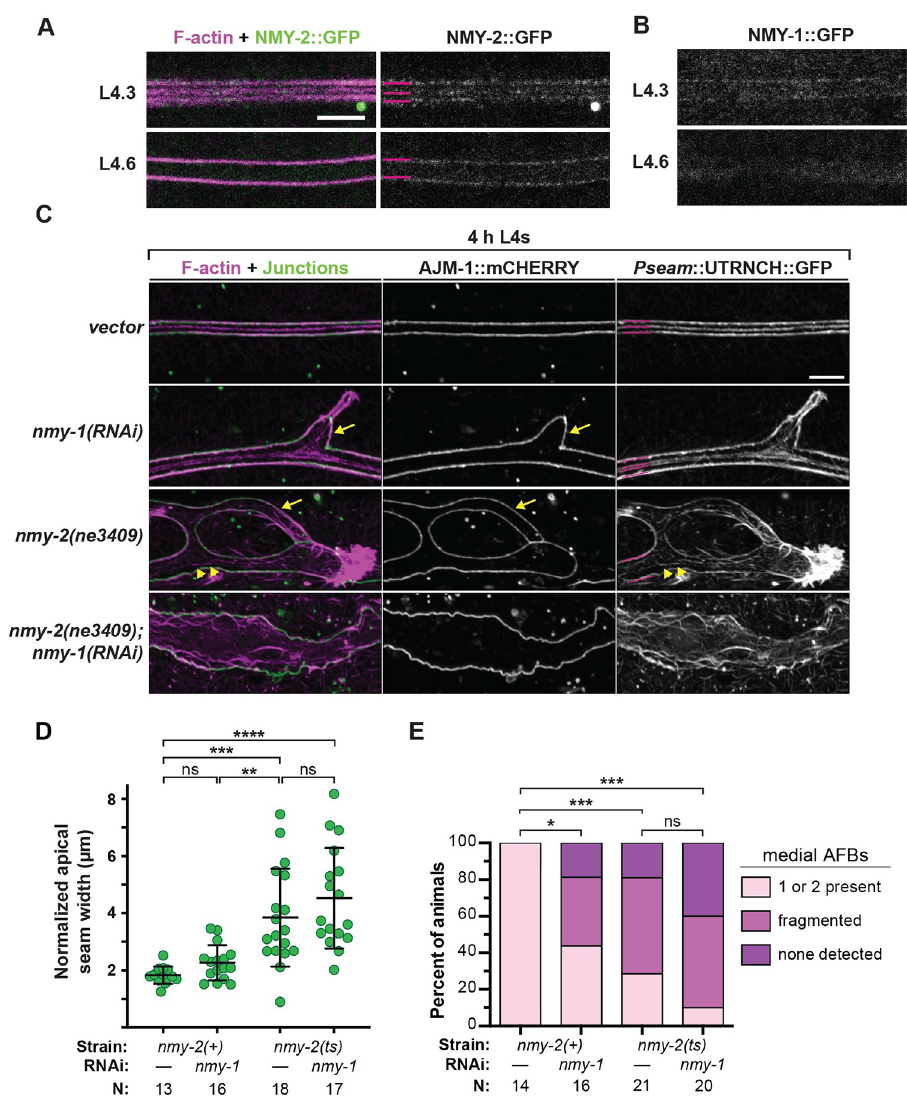
Fig 5. Longitudinal AFBs and contours of seam syncytia depend on NM II. (A) Endogenous NMY-2::GFP aligns with junctional AFBs at the seam-hyp7 margins and with the medial AFB in narrowed (L4.3-L4.4) seam syncytia. AFBs were marked by P egl-18 ::UTRNCH::dsRED (strain ARF500, 20˚C). (B) Endogenous NMY-1::GFP also faintly marks seam-hyp7 margins (strain ML2540, 20˚C). Both A and B show single confocal slices representative of at least 6 animals per stage. (C) Representative confocal maximum projections show F-actin and AJs in seam syncytia of mid-L4 animals that expressed Pegl-18 ::UTRNCH::GFP and AJM-1::mCHERRY (strain ARF404, 25˚C). Magenta lines label longitudinal AFBs. Arrows point to extensions of seam over hyp7. Asterisks label aggregated F-actin. Arrowheads point to fragmented medial AFBs. Scale bar: 5 μ m. (D) Quantitation of seam width—values are the area surrounded by AJs normalized to imaged interval. Bars signify mean and sd; ���� P � 0.0001, ��� P � 0.001, �� P � 0.01, ordinary Anova with Tukey’s test for multiple comparisons. Images and measurements from two independent trials; total sample sizes as indicated.(E) Quantitation of UTRNCH::GFP patterns. � P < 0.01, ��� P < 0.0001, Fisher’s Exact